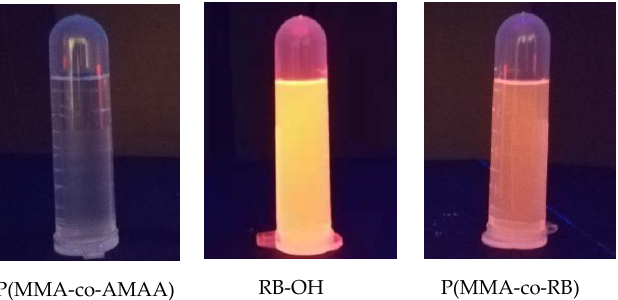
Figure 3. Photographs recorded under UV light 365 nm of P(MMA-co-AMAA) (0.5 mg/mL), RB-OH (0.05 mg/mL) and P(MMA-co-RB) (0.5 mg/mL) in DMF solution.